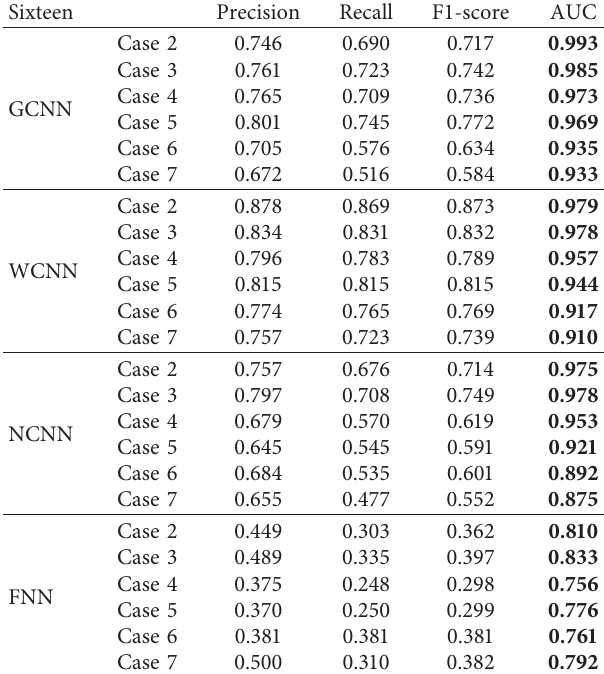
Table 7: Performance of different deep learning methods in six- teen-classes